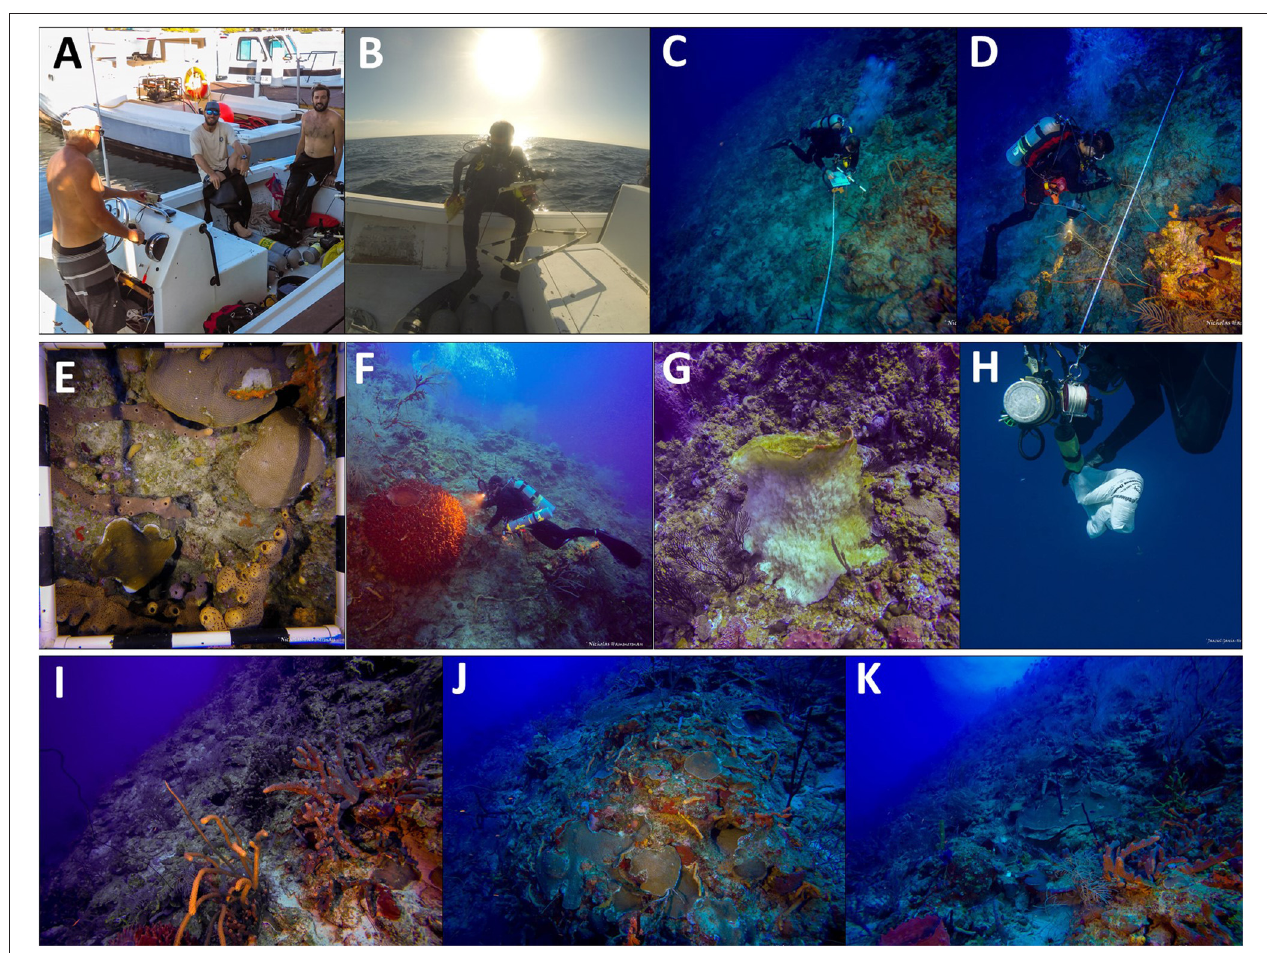
FIGURE 2 | (A) Research team, Milton Carlo, Phillip Sanchez, Nicholas Hammerman. (B) NMH with photo-quadrat. (C) PJS performing fish surveys. (D) JEGH performing visual sponge surveys/collections. (E) Photoquadrat example. (F) Healthy X. muta at 40m, PJS for size reference. (G) Specimen of X. muta affected by unknown disease or bleached. (H) Plastic bag recovered by NMH. (I–K) Upper mesophotic coral reefs along the Guánica continental shelf edge